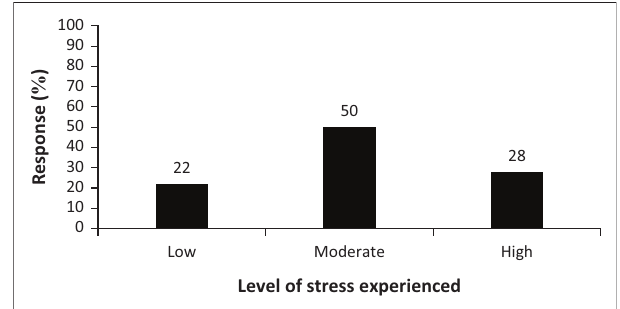
FIGURE 3: Level of stress experienced. TABLE 1: Perceived level and frequency of stress and mindset. Variable 1